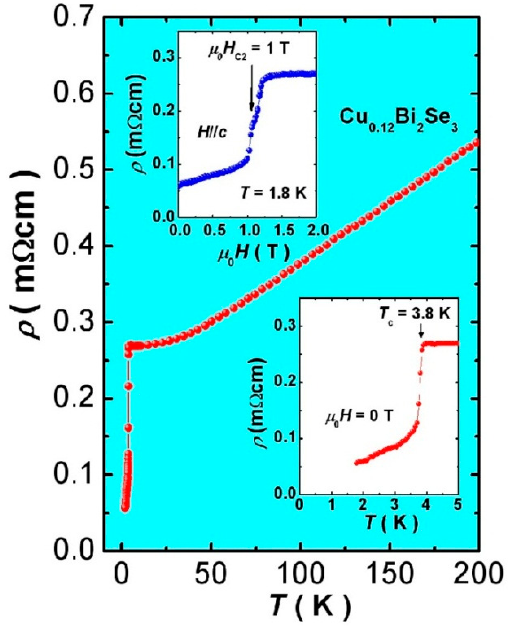
Figure 6. The temperature dependent resistivity of a Cu 0.12 Bi 2 Se 3 single crystal [72].